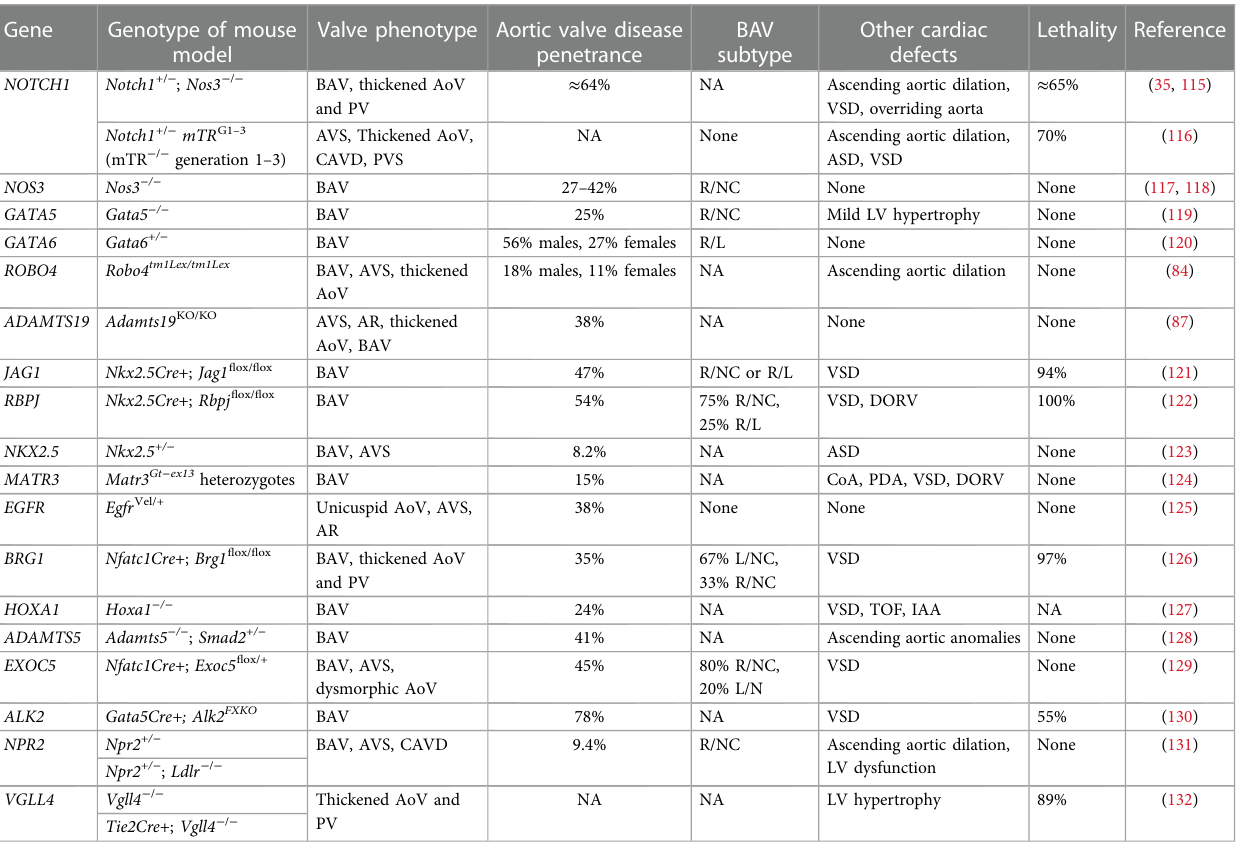
TABLE 3 Mouse models of congenital aortic valve disease.